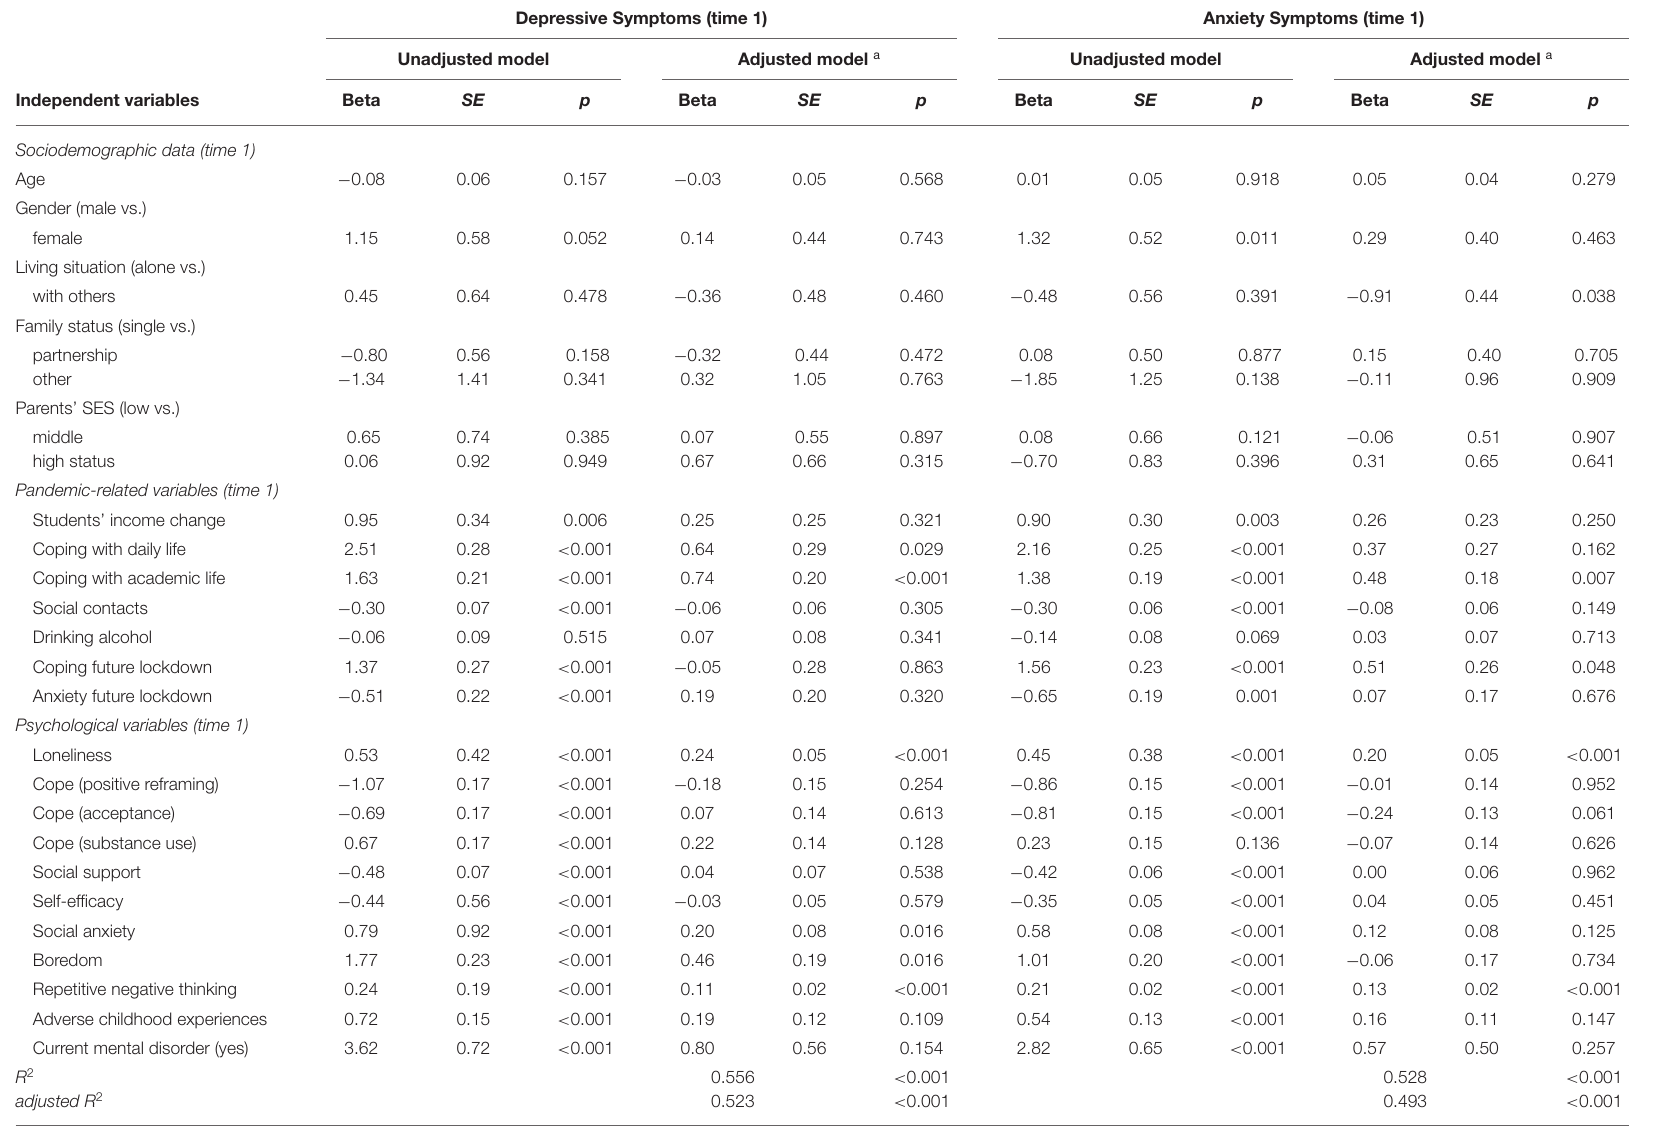
TABLE 4 | Associations with the two dependent variables depressive symptoms and anxiety symptoms at time 1 (N = 363) using simple linear (unadjusted models) and multiple linear regression analyses (adjusted models.). Depressive Symptoms (time